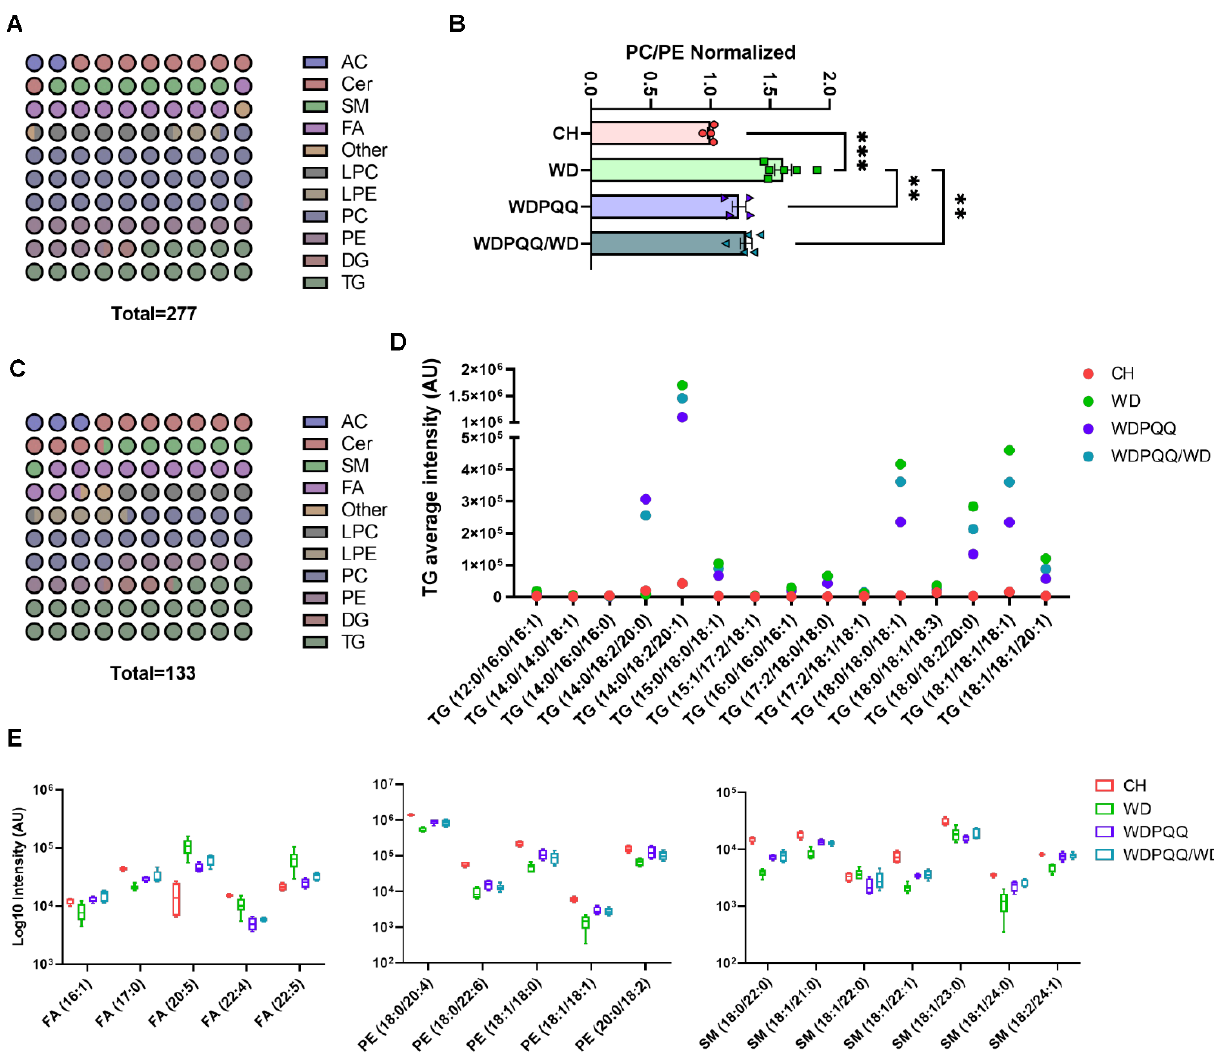
Figure 4. Exposure to PQQ alters the compositional distribution of lipids in adult liver. ( A ) Dot plot of the fractional distribution of total hepatic lipids in adult liver. ( B ) Ratio of phosphatidylcholines (PC) to phosphatidylethanolamine (PE). Data are means ± SEM. ** p < 0.01, *** p < 0.001. ( C ) Dot plot of the fractional distribution of significantly changed hepatic lipids in adult liver. ( D ) Scatter plot of average mass spectral intensities of the 15 core triglycerides. ( E ) Box plots of the log10 of the spectral intensity for lipid classes and chain lengths that were the most affected by PQQ ( n = 4 – 6/group). AC, acylcarnitines; Cer, ceramides; DG, diacylglycerides; FA, fatty acids; LPC, lysophosphatidylcholine; LPE, lysophosphatidylethanolamine; PC, phosphatidylcholines; PE, phosphatidylethanolamines; SM, sphingomyelins; TG, triglycerides.